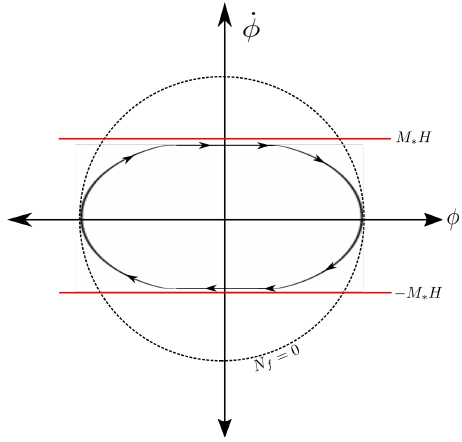
Figure 1 . The phase diagram with finite N f will be limited by the speed limit shown by the red horizontal lines in the regime of parameters described in the